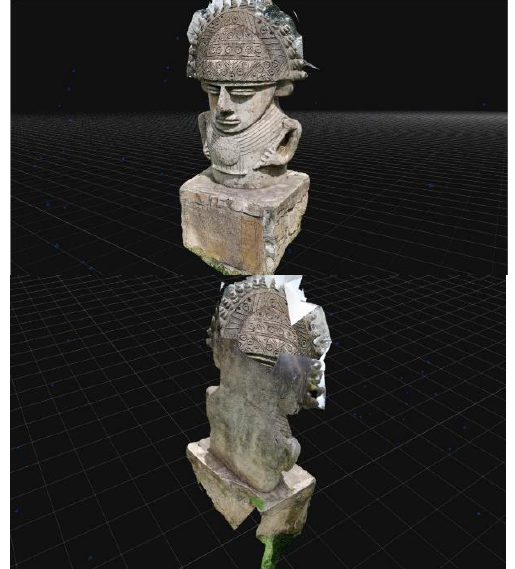
The software effectively and automatically extracted 46 frames from the video capture that was 44 seconds long, approximately one frame per second, as it was the initial setting of the conventional camera.